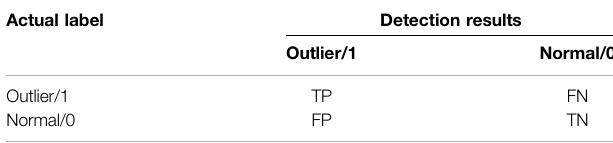
TABLE 1 | Confusion matrix of outliers detection.